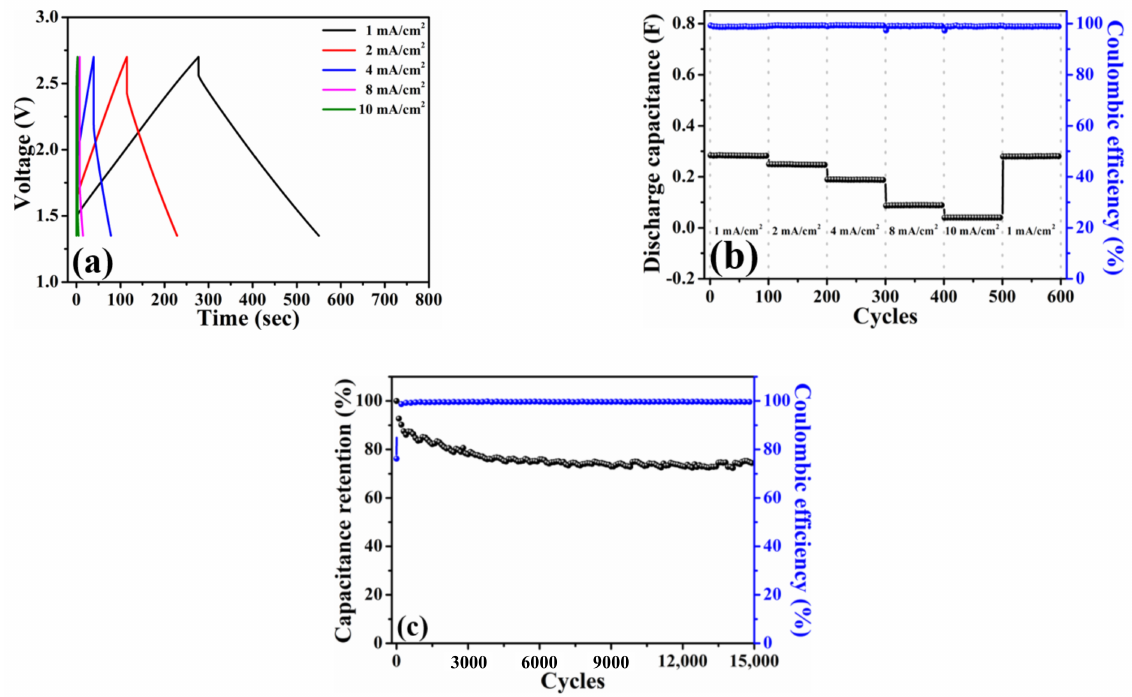
Figure 4. ( a ) Galvanostatic charge–discharge profiles, ( b ) rate capabilities, and ( c ) capacitance retention of a coin-type symmetric cell with high-mass loading hierarchically porous activated carbon electrodes in 1.35–2.7 V. The current densities used in ( a , b ) are 1 mA/cm 2 (0.12 A/g) to 10 mA/cm 2 (1.2 A/g), whereas the current used in ( c ) is 5 mA (i.e., 0.45 A/g and 3.76 mA/cm 2